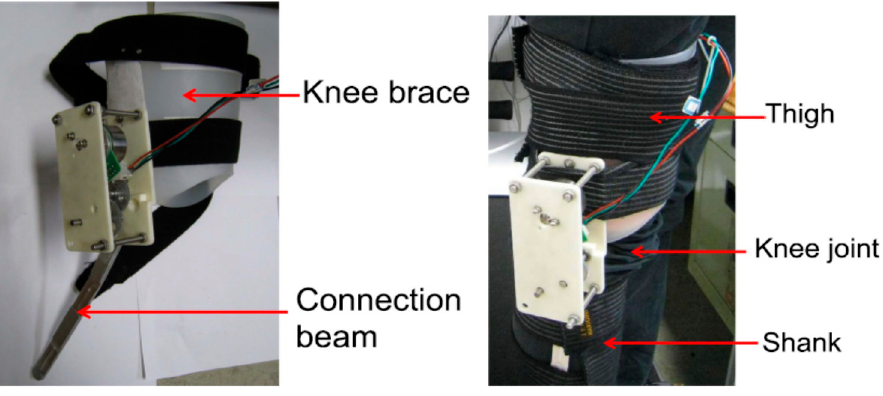
Figure 10. Knee wearable energy harvester with unidirectional generator rotation [48]. Reproduced with permission from IOP Publishing.